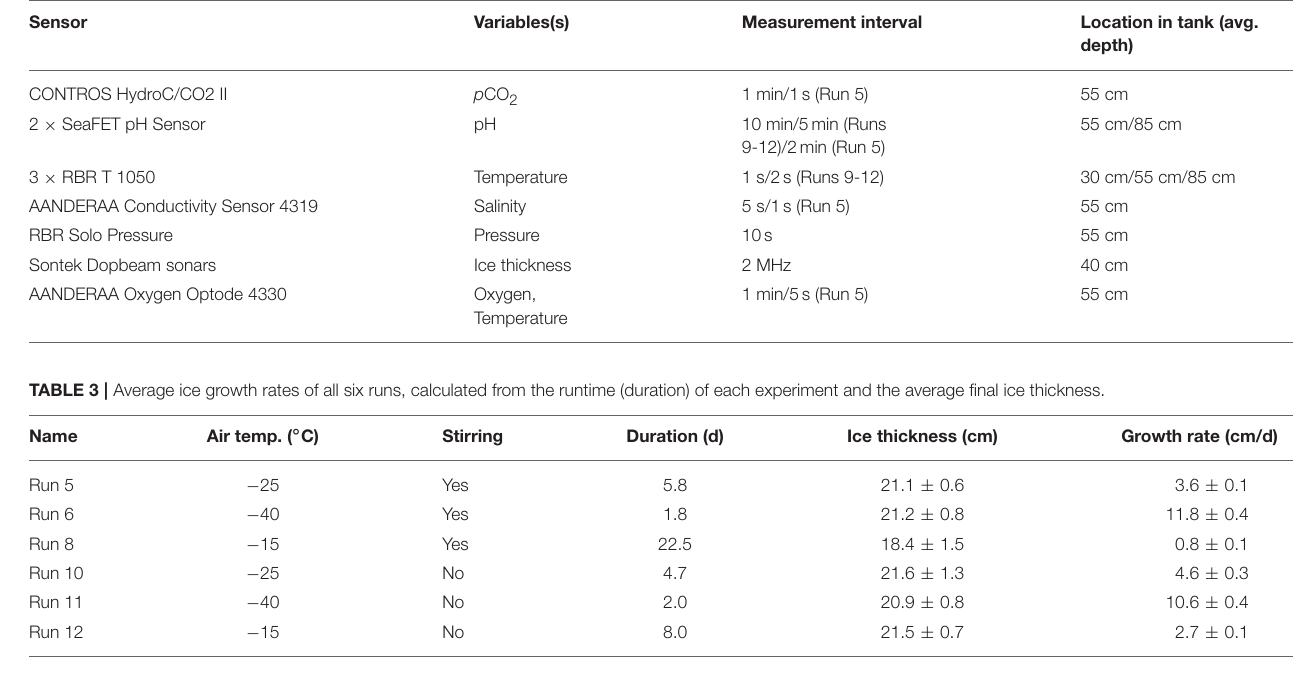
TABLE 2 | Overview of sensors deployed in the seawater tank. Additional sensors installed but not discussed in this paper are described in König (2017).